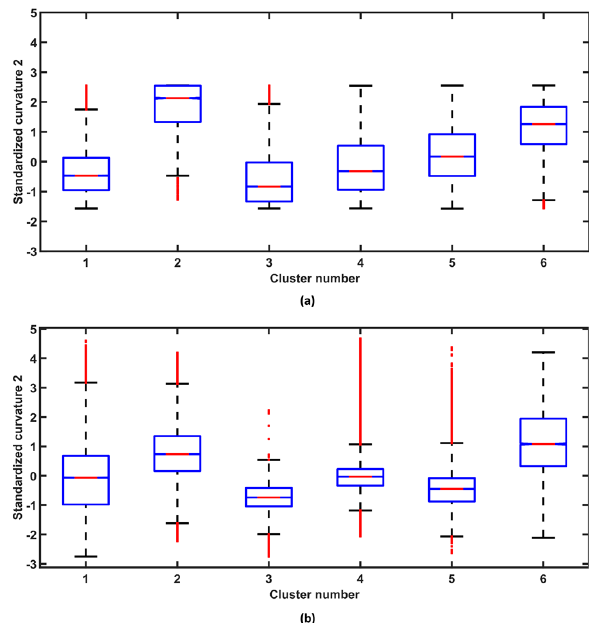
Figure 9. Boxplot showing a comparison of standardized curvature 2 features (extracted from small voxels) for each cluster for ( a ) the TLS point cloud and ( b ) the UAS-SfM point cloud solutions with number of clusters equal to 6. The more compact the box and its fences are, the more similar the points within that cluster. The larger the box and its fences are, including potential outliers in red, the more heterogeneous the cluster. Clusters with overlapping boxes have curvature 2 distributions with similar central tendencies while non-overlapping boxes indicate a good di ff erentiation in curvature 2 values between the clusters.